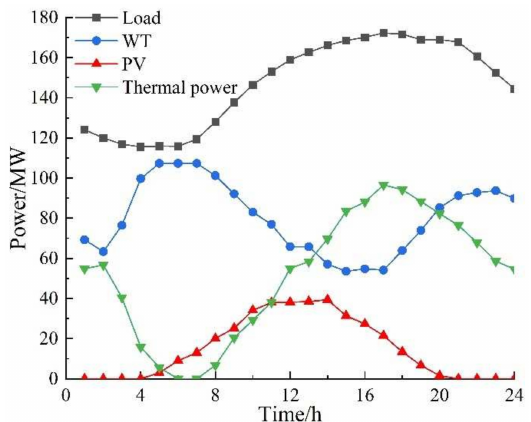
Figure 19. Typical daily power curve for scenario 4.